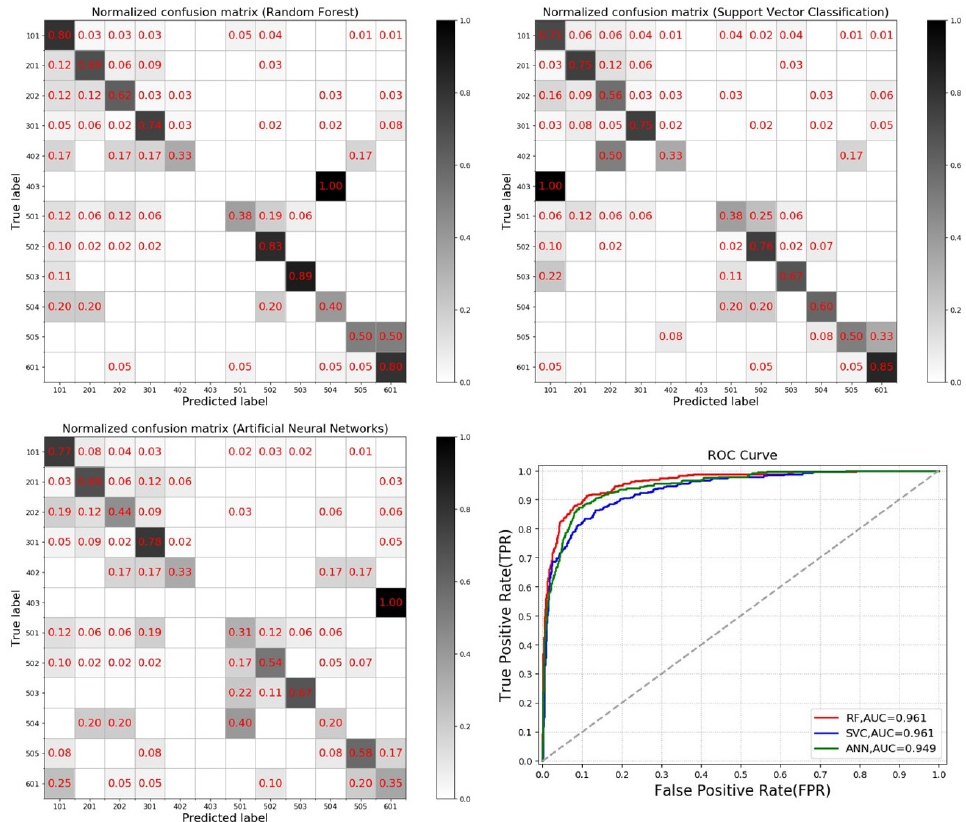
Figure 8. Confusion matrix and ROC curve of the Level II land-use classification.